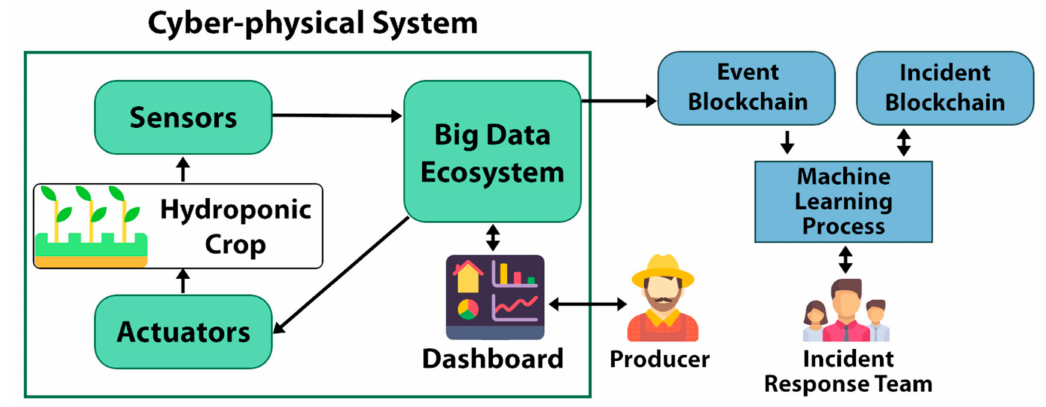
Figure 6. General architecture of the case